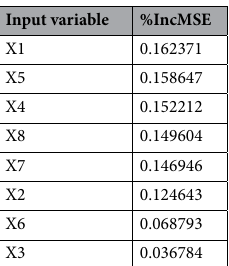
Table 5. Tanking of importance of